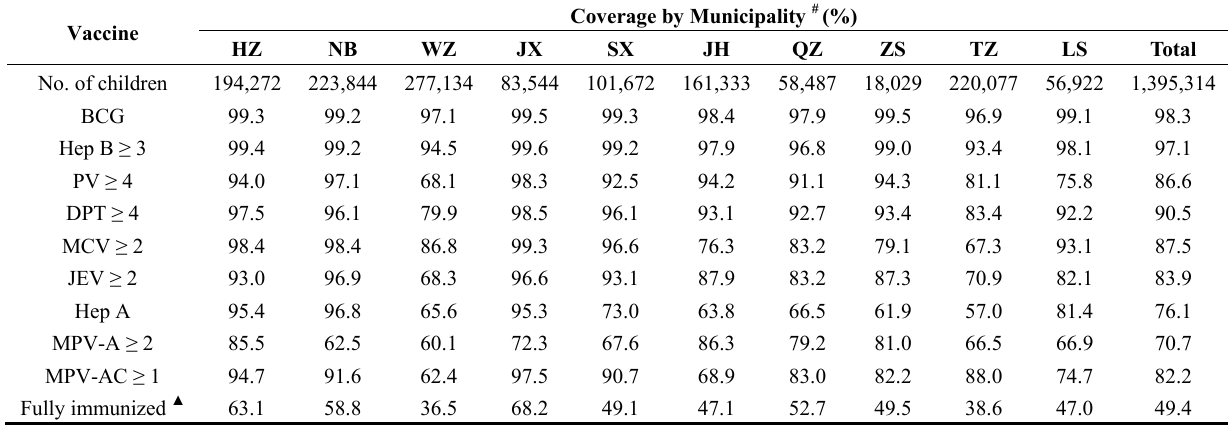
Coverage by Municipality #